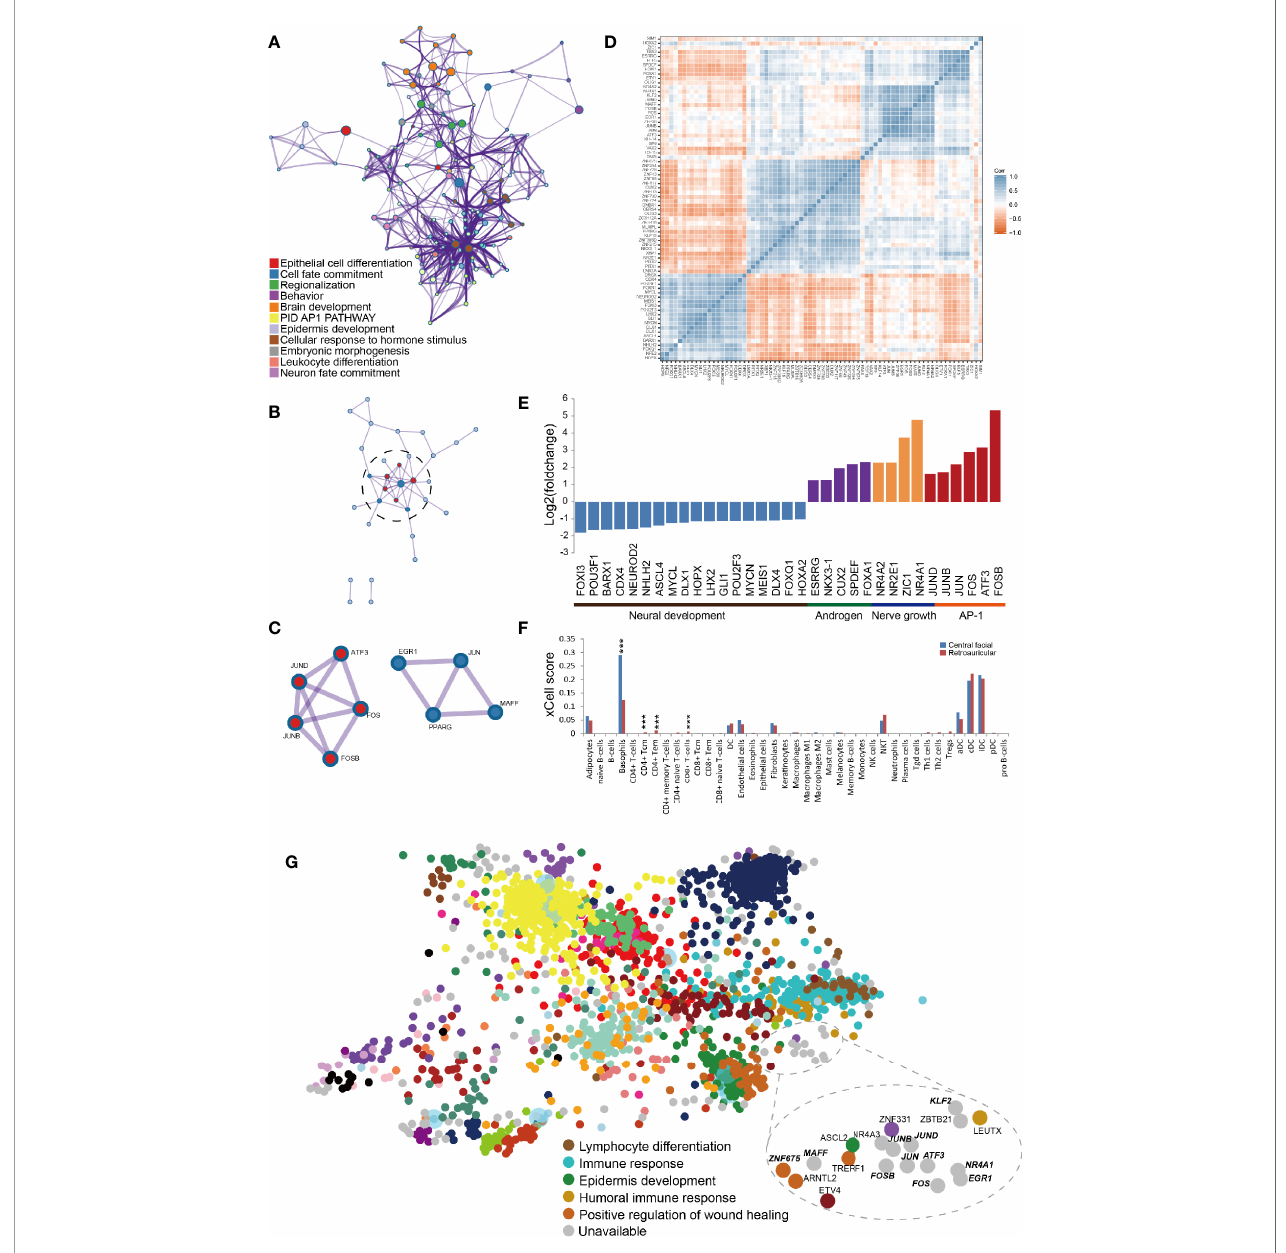
FIGURE 2 | Transcription factors (TFs) related to transcriptional pro fi ling in central facial skin. (A) Metascape network analysis of enriched GO terms and KEGG pathways for TFs highlights cellular response to hormone stimulus, brain development and regionalization biological processes. (B) Metascape network analysis of the complex interactome network for TFs indicating the connection between the AP1 pathway and cellular response to hormone stimulus. (C) Genes composing the complex of the AP1 pathway (red color) and cellular response to hormone stimulus (blue color). (D) Correlation heatmap representing signi fi cant correlation of expression of TFs by transcripts per million kilobases (TPM). Blue squares indicate signi fi cant positive correlation (r>0.5, p<0.05), white squares non-signi fi cant correlation (p>0.05), and red squares signi fi cant negative correlation (r< − 0.5, p<0.05). (E) Manual classi fi cation of biological process for TFs by their function. (F) The xCell-inferred enrichment score of cell types in central facial skin (blue color) and skin surrounding the auricle (red color). The xCell scores predict relative enrichment for cell types, not the extract proportions. ***P<0.001. (G) TF cluster generated by ChEA3, which prioritizes TFs based on overlap between our TFs and previously annotated TF targets assembled from multiple resources. The TFs identi fi ed in this study are highlighted by bold italics. The results demonstrate TFs enriched in the AP1 pathway and cellular response to hormone